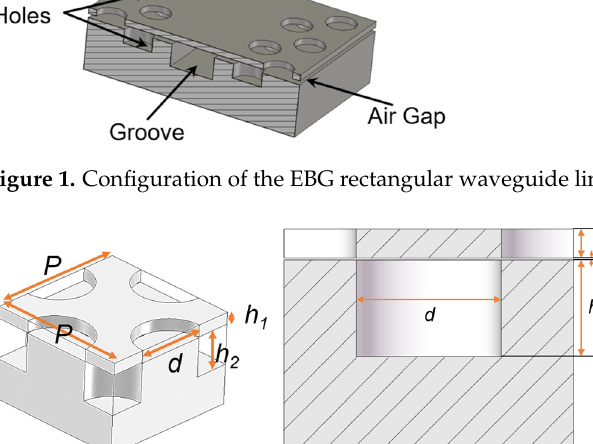
Figure 2. Configuration of the unit cell with glide-symmetric holes, consisting of two metal layers.